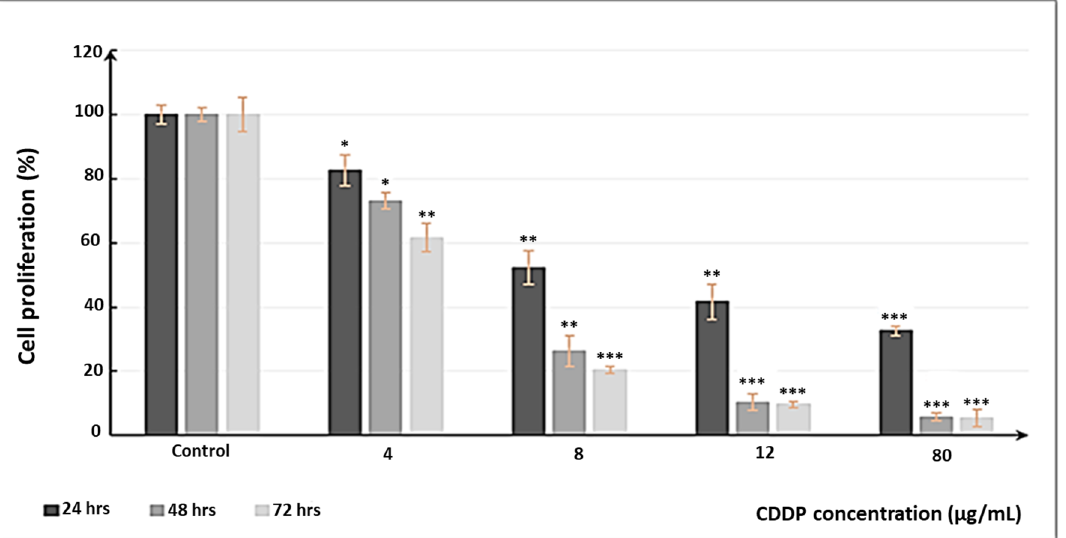
Figure 7. Cell proliferation of A549 cells after exposure to gradual increasing concentrations of CDDP alone for 24, 48, and 72 h. Peak values are represented as mean +/ − SD. Statistical analysis: Paired t test or Wilcoxon test. * p < 0.05; ** p < 0.01; *** p < 0.001 in which percentage of proliferation of treated cells is compared with that of control at 24, 48, or 72 h.